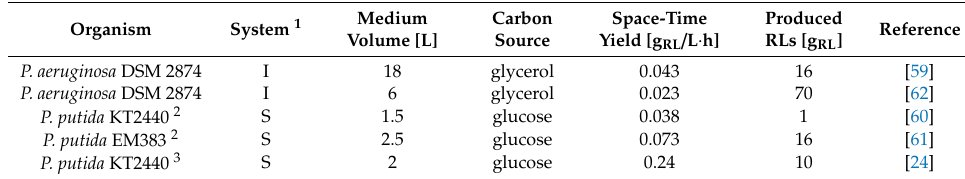
Table 1. Fermentative RL production and separation via integrated and non-integrated foam fractionation systems.